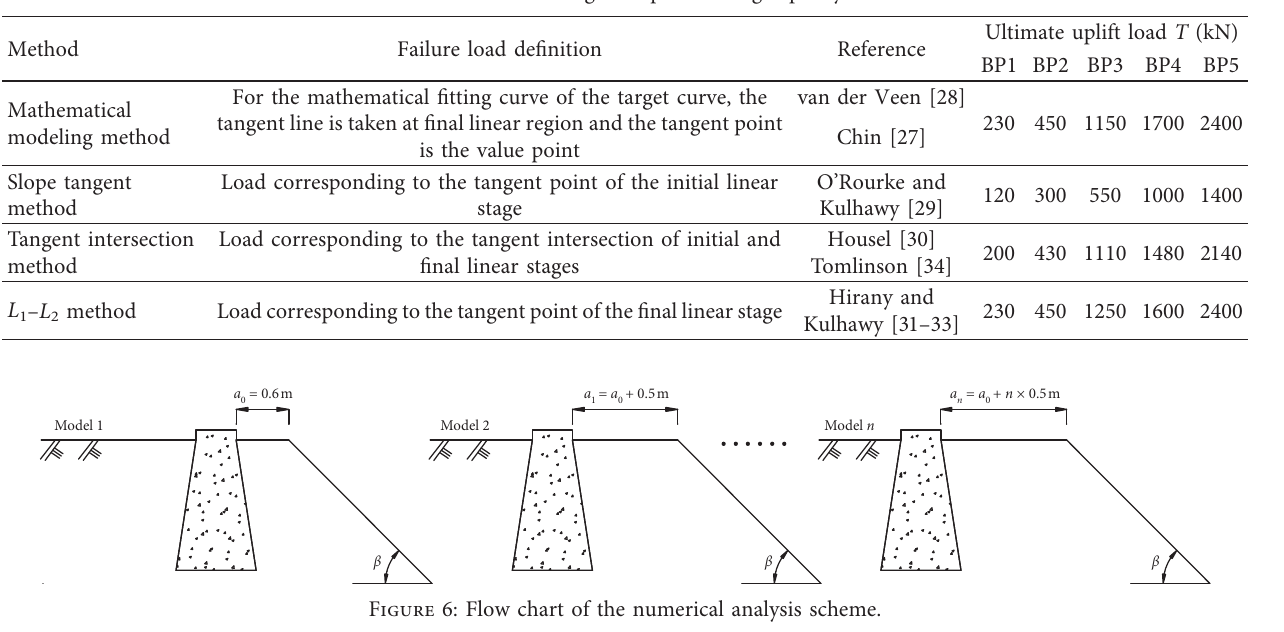
Figure 5: Sections of the load-displacement curve for the L Table 4: Failure criteria for determining the uplift bearing capacity of test